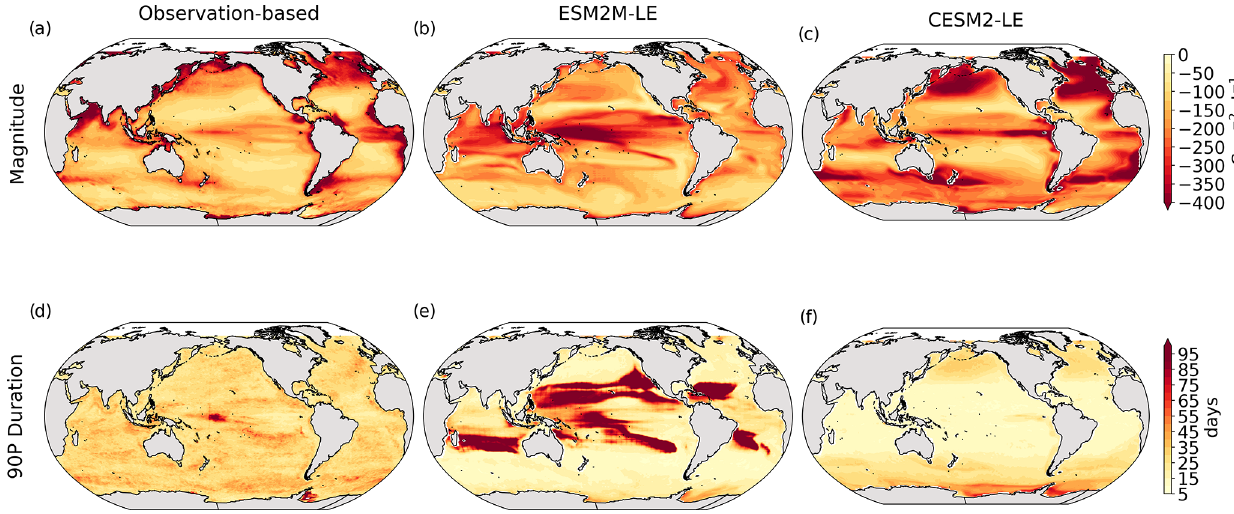
Figure B3. Simulated mean magnitude and duration of NPPX events over 1998–2018. Mean NPP anomaly relative to the seasonal cycle (mgCm − 2 d − 1 ) during NPPX events in (a) observation-based estimates, (b) ESM2M-LE, and (c) CESM2-LE. The 90th percentile of the NPPX events duration (days) in (d) observation-based estimates, (e) ESM2M-LE, and (f) CESM2-LE. The global mean magnitude equals − 209, − 182 and − 223mgCm − 2 d − 1 , while the global mean 90th percentile of the duration equals 29, 34, and 18d in the observations, ESM2M-LE, and CESM2-LE,